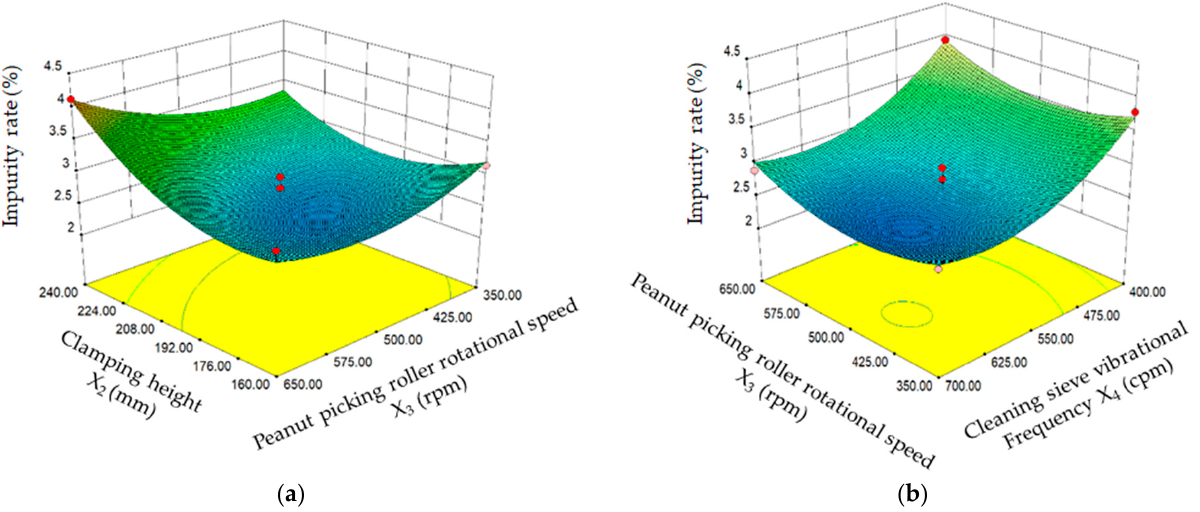
Figure 10. Effects of the interaction factors on the impurity rate. ( a ) Interaction of X 2 with X 3 for X 1 = 1.0 m/s, X 4 = 600 cpm. ( b ) Interaction of X 3 with X 4 for X 1 = 1.0 m/s, X 2 = 200 mm.